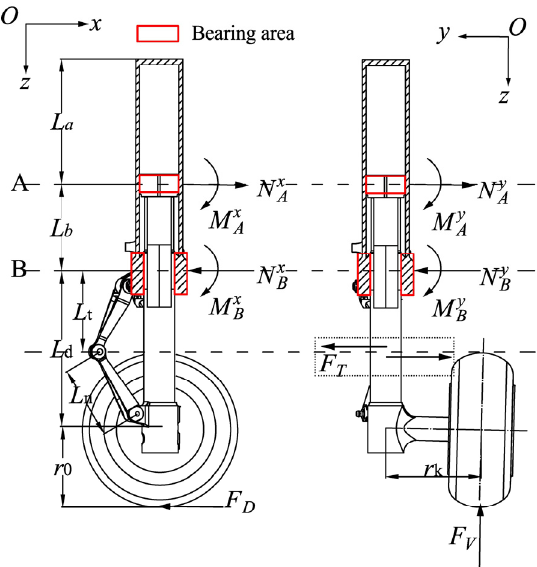
Figure 3. Schematic of main landing gear (MLG) load analysis.